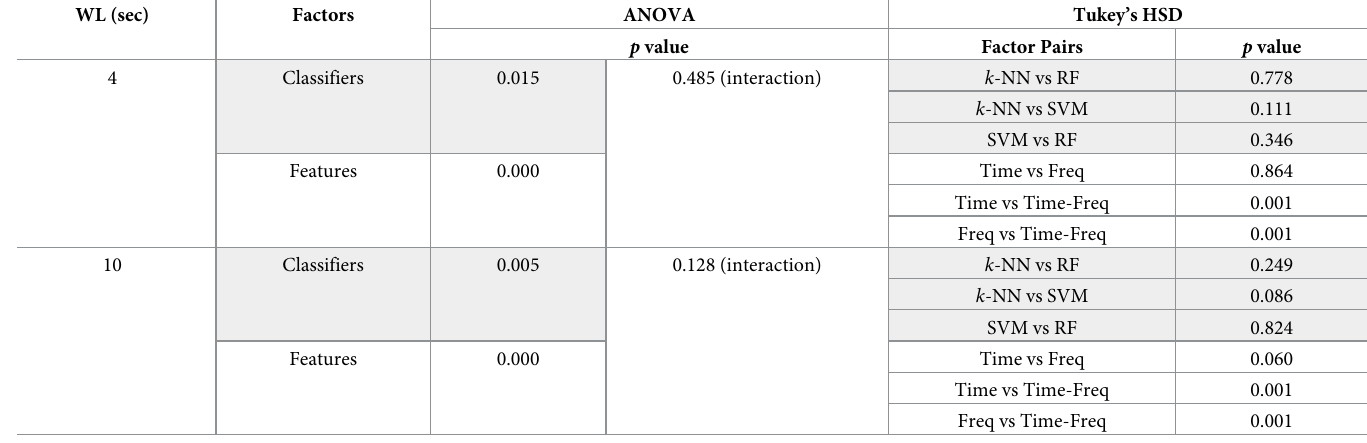
method on 30 observations that were correctly classified for the two tasks. The feature contri- butions were averaged over the 30 observations. 3.4.1 Electrical panel. The top panel in Fig 7 presents the feature importance for the elec- trical panel task from LIME method for the frequency and time-frequency features. From this figure, the features from Z acceleration are the most important in both feature sets. Also, from the time-frequency domain features, the second and third most important features are selected from the X acceleration signals. These observations are in contrast with the overall feature importance from the RF classifier, and reaffirm that feature importance should be investigated for individual classes. We selected a sample observation out of the 30 observations used to cal- culate the feature importance for electrical panel and reconstructed the signal using the impor- tant features. The reconstructions from the frequency and time-frequency features are presented in the bottom panels of Fig 7. For the frequency domain features, only two (out of 30) were selected from the X signal. The reconstruction shows a simple periodic pattern. From the time-frequency domain fea- tures, three (out of 15) features were selected from the X signal and the reconstruction from the time-frequency domain features set showed an emphasis on the abrupt changes from the X signal to classify the task. Table 6. Two-way ANOVA for main and interaction effects of classifier and feature on inter-subject overall accuracy and Tukey’s HSD for significant effects (p < 0.05). Analyses are performed separately for each window length. WL (sec) Factors ANOVA Tukey’s HSD p value Factor Pairs p value